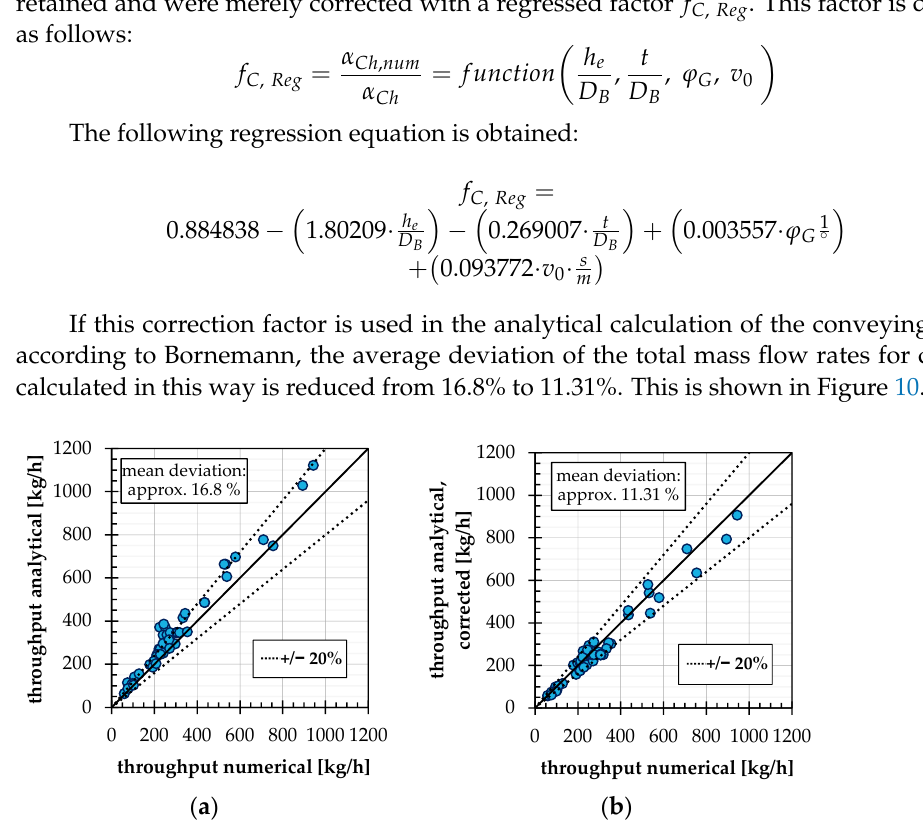
Figure 10. ( a ) Comparison of the numerically determined throughputs in conveying case 2a with the analytical model according to Bornemann; ( b ) comparison of the numerically determined throughputs in conveying case 2a with the analytical model according to Bornemann, corrected with regression factor 𝑓 𝐶,𝑅𝑒𝑔 .